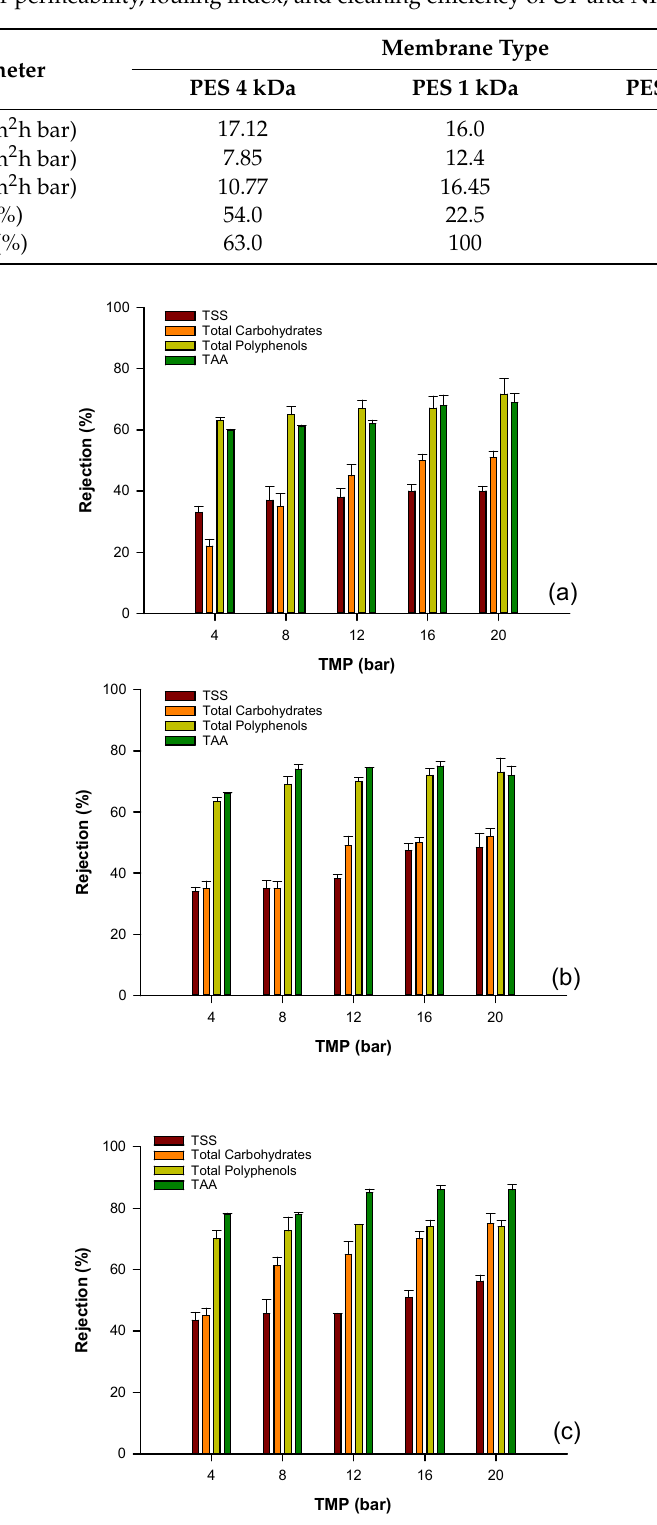
Figure 7. Rejection by UF and NF membranes of analyzed compounds: ( a ) PES 4 kDa; ( b ) PES 1 kDa membrane; ( c ) PES 0.3 kDa membrane.